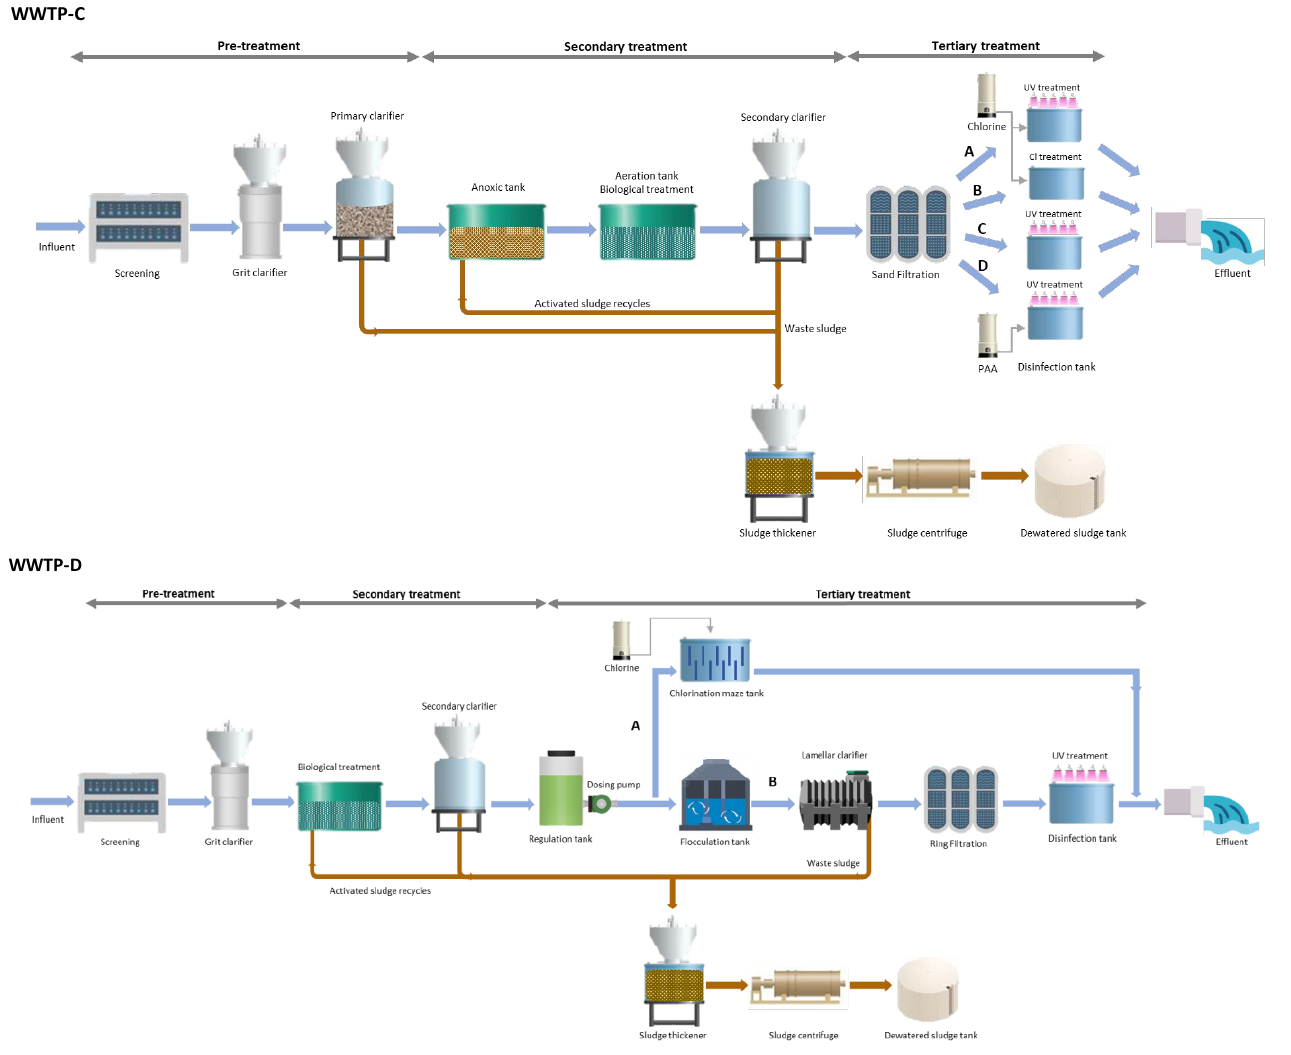
Figure 1. Schematic diagram of each WWTP including pre-, secondary and tertiary treatments applied.